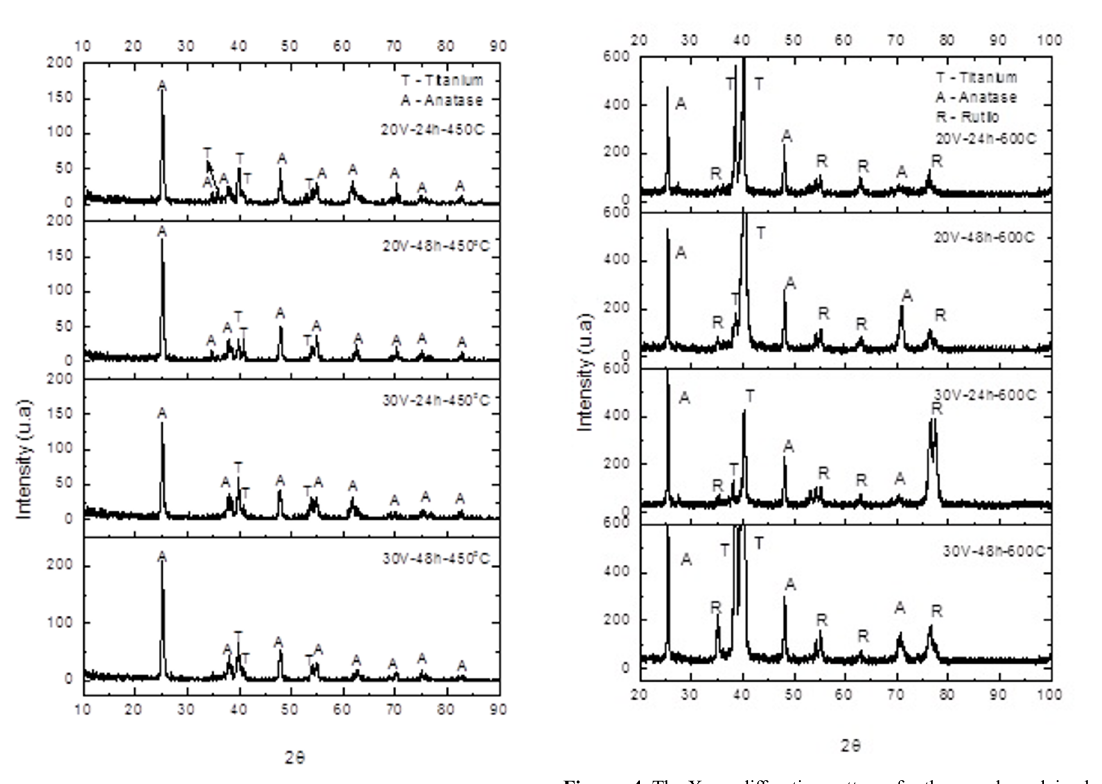
Figures 3. The X-ray diffraction patterns for the samples calcined at 450 ºC.